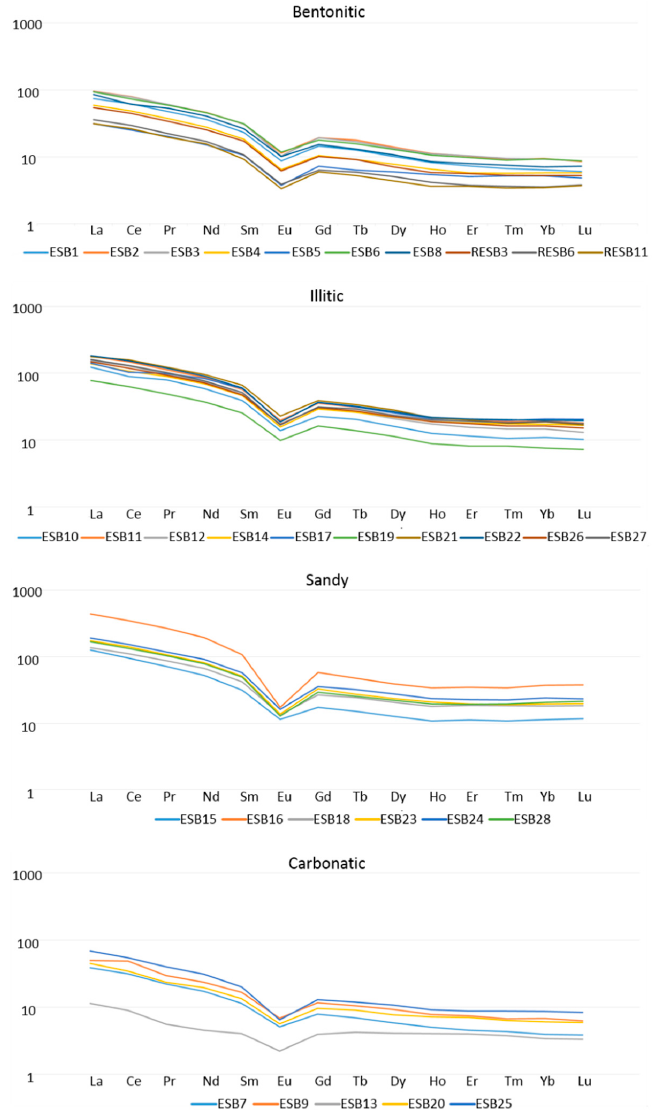
Figure 4. Chondrite normalized rare earth element (REE) patterns.